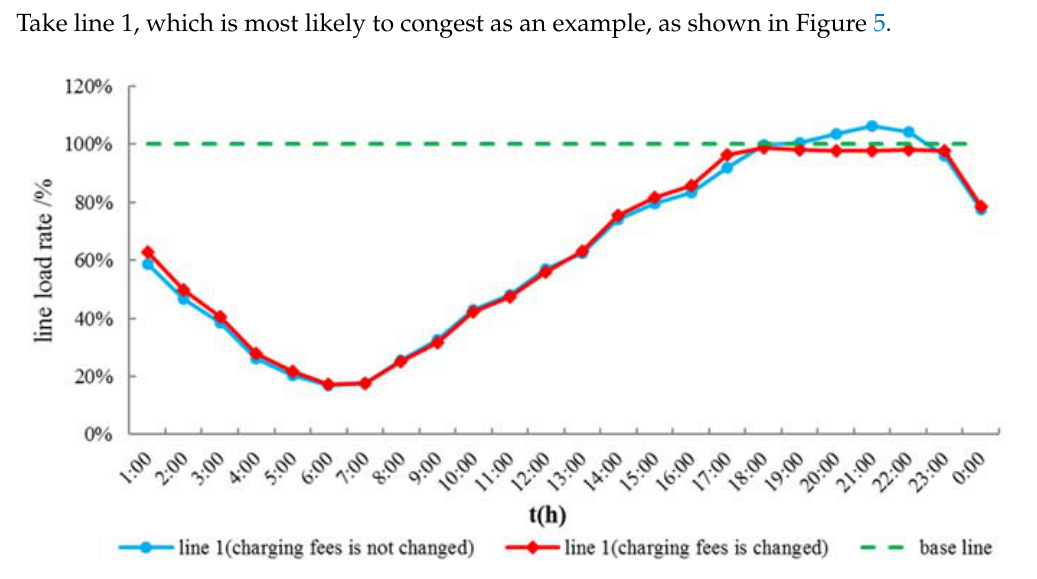
Figure 6. Line load rate of line 4 before and after adjustment for charging fees. The real-time charging fees for three charging stations after optimization is shown in Figure 7. In the case of free charging mode, the charging cost of the owner is 17,601 yuan. After implementing the real-time charging fees policy, the charging cost is 15,433 yuan, and the owners have a high satisfaction rate of 85%. The congestion problem of the distribution network is solved while taking into account the interests of the owners and the operators.